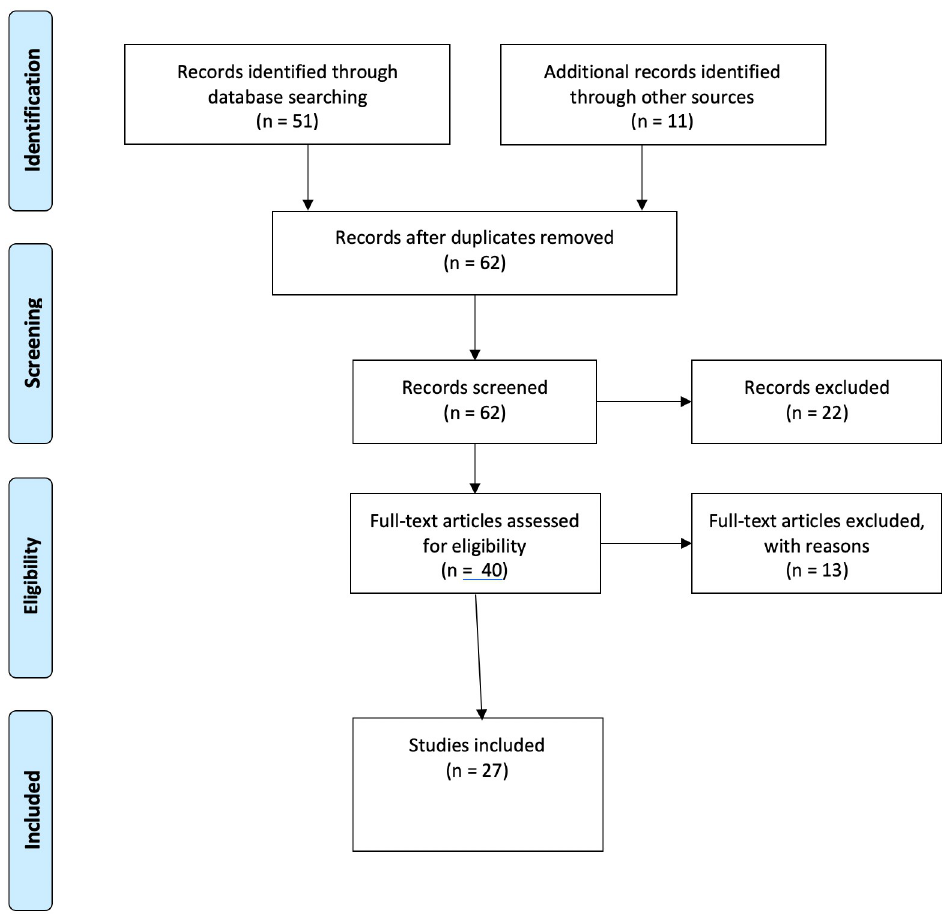
Fig 1. PRISMA flow diagram of identified, screened, eligible and included